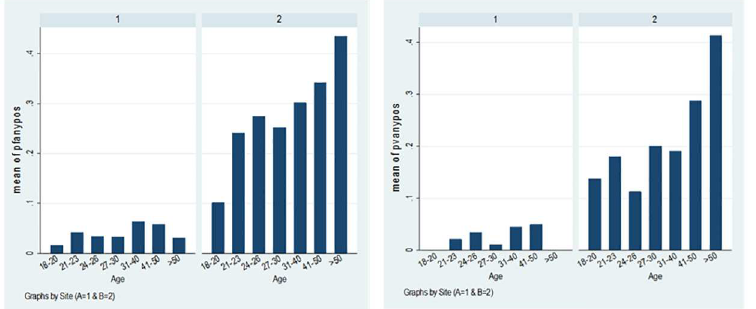
Fig 1. Mean of seropositivity to any tested antigens for P . falciparum (left) and P . vivax (right) by age